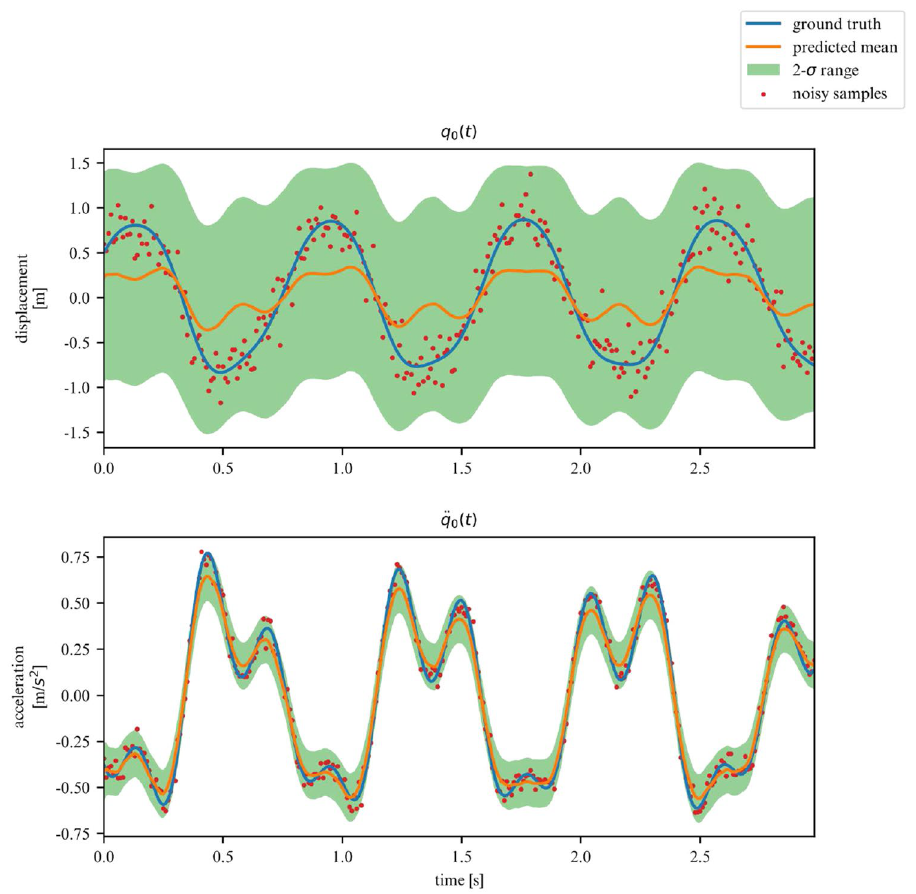
Figure 20. Partially observed linear 3DOF